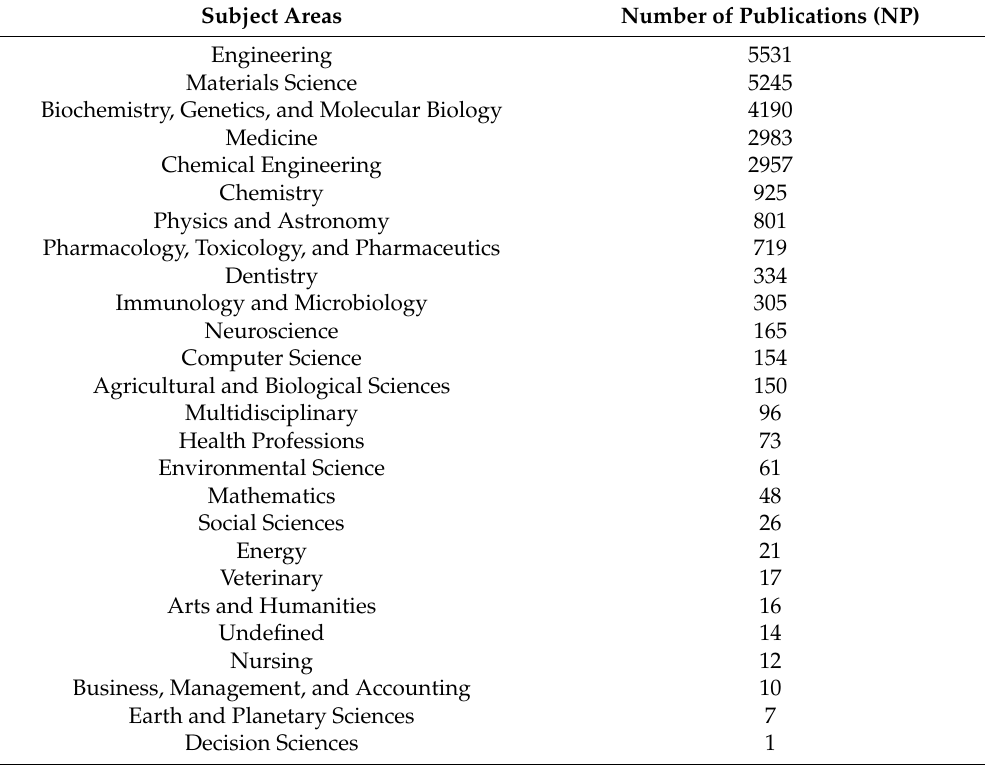
Table 3. Subject areas found in query